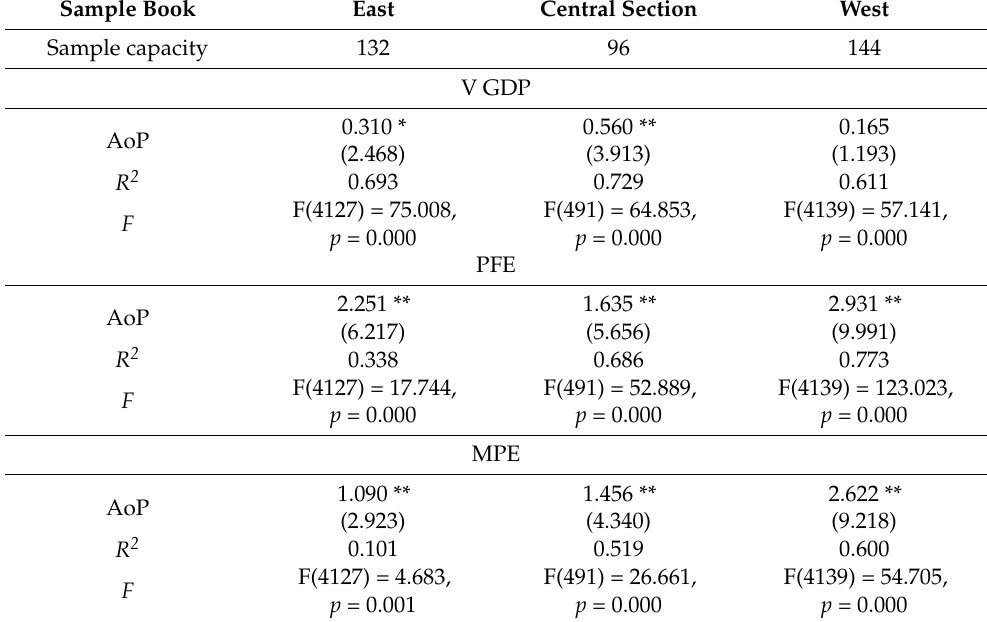
Table 8. Results of sub-sample regression on the effects of population aging.